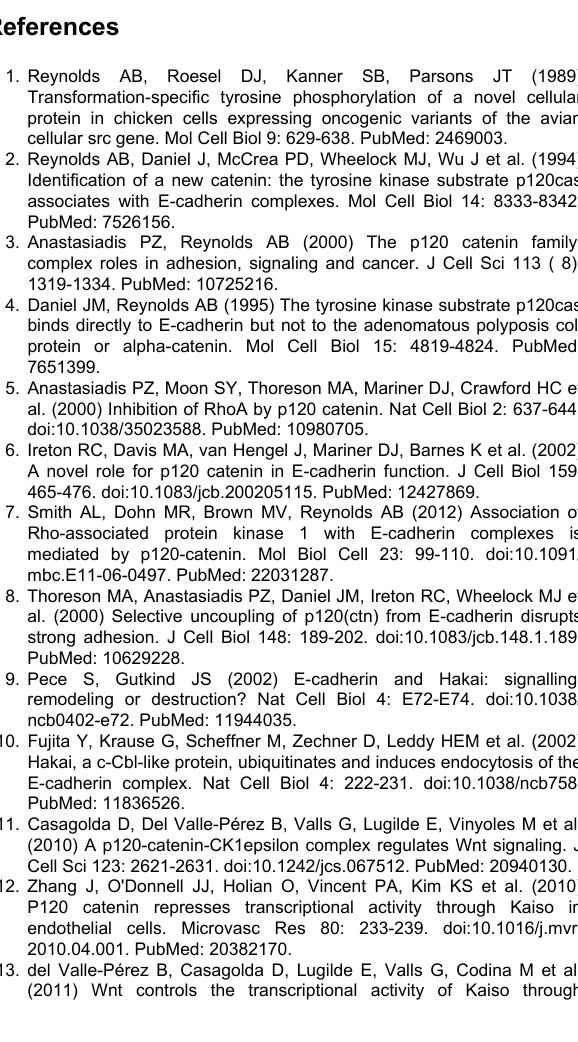
Table S1. Primers pairs used in this study. Primer pairs used for qRT-PCR are shown.